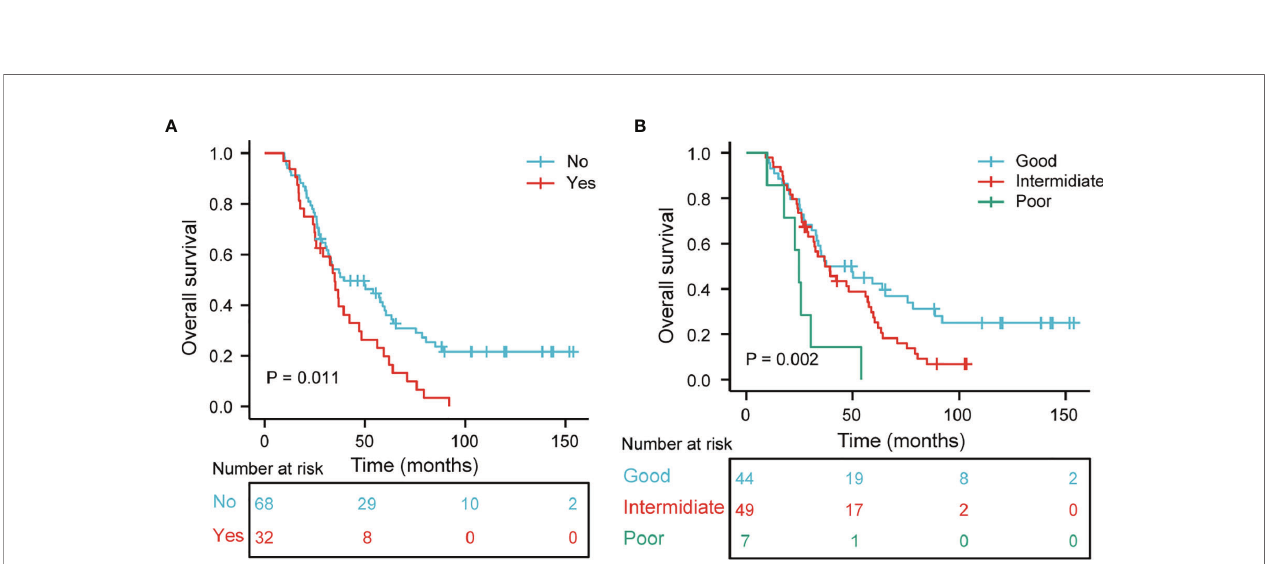
FIGURE 4 | (A) Kaplan – Meier curves and log-ranks tests of overall survival in stage III SCLC patients according to brain metastasis. (B) Overall survival subgroup analysis according to tumor location and MLR (p =